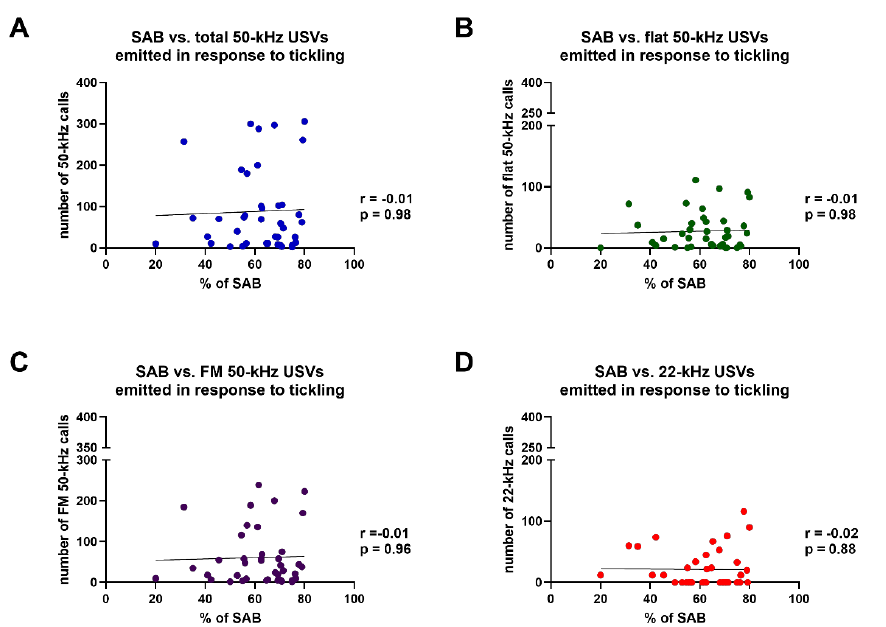
Figure 9. Results of Spearman’s correlation test between the percentages of spontaneous alternation behavior and the numbers of total 50-kHz ultrasonic vocalizations ( A ), flat 50-kHz ultrasonic vocal- izations ( B ), frequency modulated 50-kHz ultrasonic vocalizations ( C ) or 22-kHz ultrasonic vocali- zations ( D ) emitted in response to tickling. FM = frequency modulated; SAB = spontaneous alterna- tion behavior; USVs = ultrasonic vocalizations. n = 40.